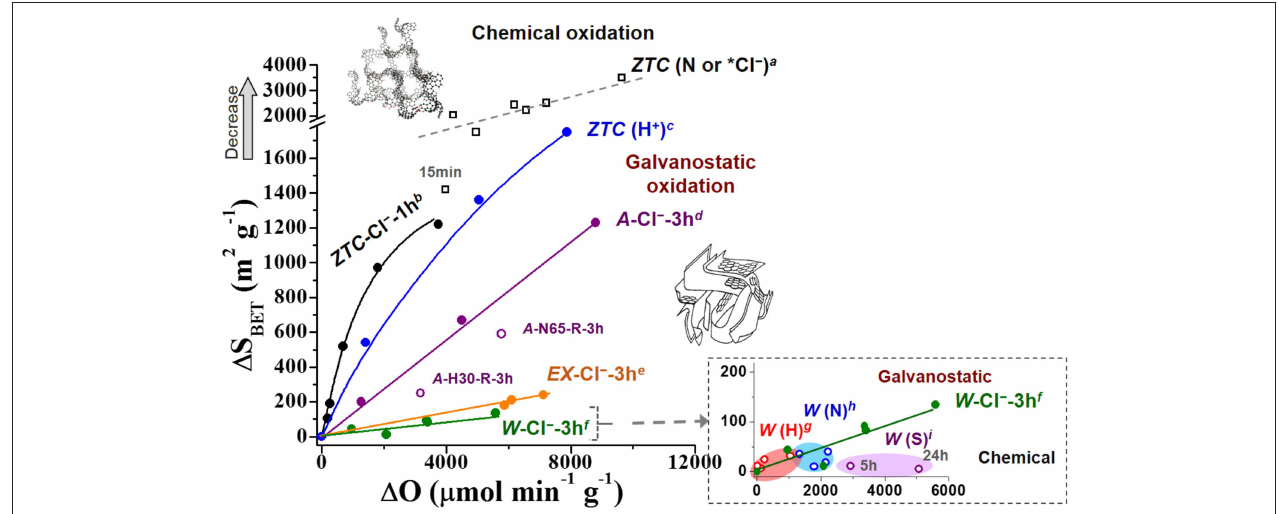
FIGURE 1 | Extent of oxidation ( 1 O) and surface area variation (decrease) caused by most common chemical reagents in liquid phase [H 2 O 2 , HNO 3, and (NH 4 ) 2 S 2 O 8 ] and different galvanostatic treatments at different conditions on the studied microporous materials. The carbonaceous structures of the ZTC and the ACs are adapted from Nishihara et al. (2009) and Rodríguez-Reinoso and Molina-Sabio (1998), respectively. Note: (*Cl − ) refers to the too strong electrochemical conditions for the oxidation of ZTC ( ≥ 50mA in NaCl) at which their oxidizing power approaches those of chemical treatments. Oxidation conditions: a : 30–60 wt% HNO 3 , R − 80 ◦ C,15 min-2h; a *: 50mA, 3–7h; b : 2–20mA; c : 2–5mA, 1–36h; d , e , f : 0.2–1.0A; g : 10–33 wt% H 2 O 2 , 2h; h : 23-65 wt% HNO 3 , 2h; i : (NH